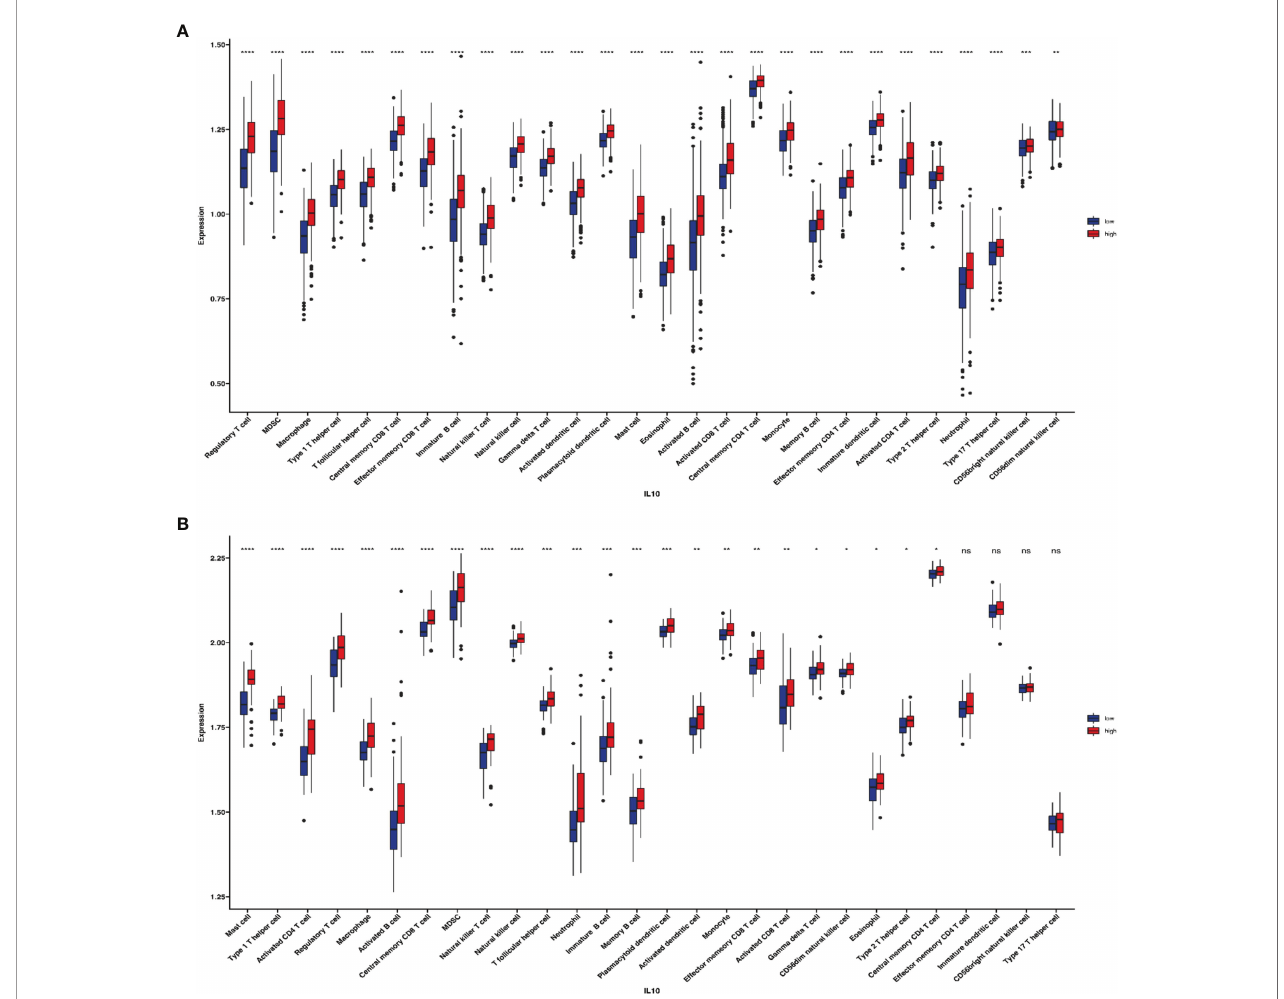
FIGURE 4 | The role of IL-10 in the immune-related cell in fi ltration. (A) Twenty-eight immune-related in fi ltration cells between high and low IL-10 groups in non-small cell lung tumor samples. (B) Twenty-eight immune-related in fi ltration cells between high and low IL-10 groups in normal samples (ns: p ≥ 0.05, *p < 0.05; **p < 0.01; ***p < 0.001; ****p <